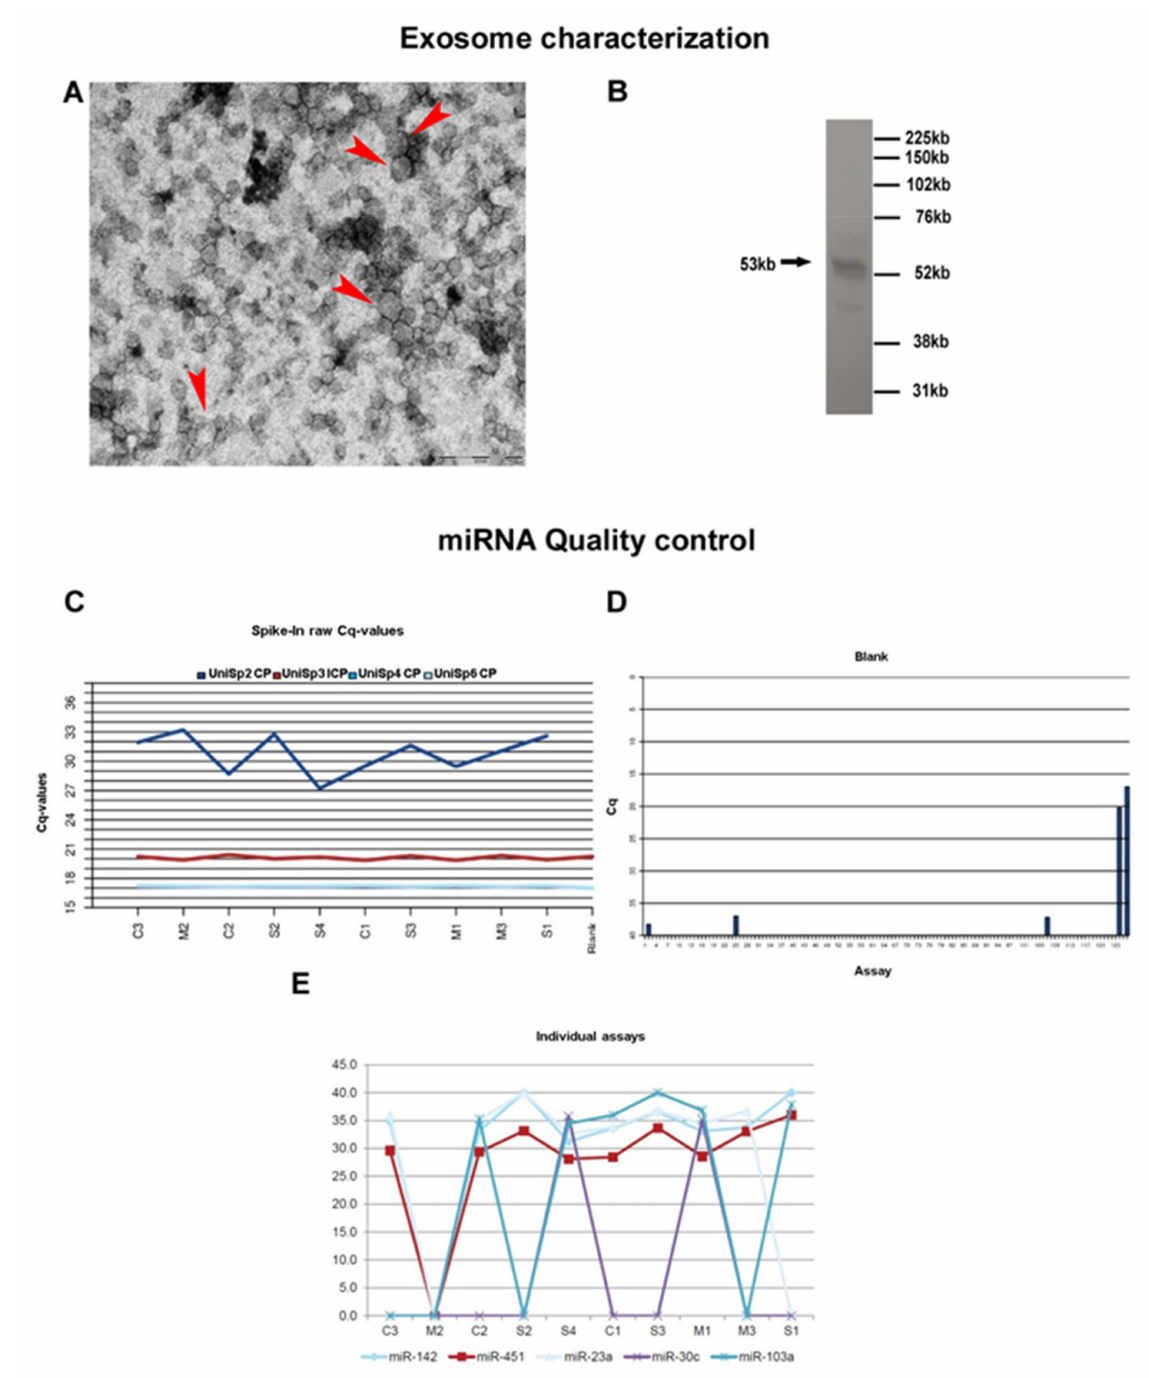
Figure 1. Exosome characterization and miRNA quality control. ( A ) Presence of exosomes in our samples was confirmed by electron microscopy (Arrow head) (scale bar 200nm) and ( B ) WB analysis. ( C ) The graph shows the sample quality control using spike-ins (RNA isolation control: UniSp2, UniSp4, UniSp5; cDNA synthesis control: UniSp6). On X axis the analyzed samples are reported (Controls: C1, C2, C3; Sporadic patients: S1, S2, S3, S4 and Mutated patients: M1, M2, M3) while Y axis shows the raw Cps obtained for the control assay. ( D ) Bar diagram showing raw Cp values for the negative control sample. Assays are reported on X axis while Cq levels are reported on Y axis. No signal was detected for the negative control. The positive controls on the plates (DNA and RNA spike ins) yields detectable signals as expected (far right). ( E ) The graph shows the average Cp levels for all the tested samples. On X axis the analyzed samples are reported while Y axis represent the Cp levels of miRNAs known to be expressed in a majority of sample types at a steady